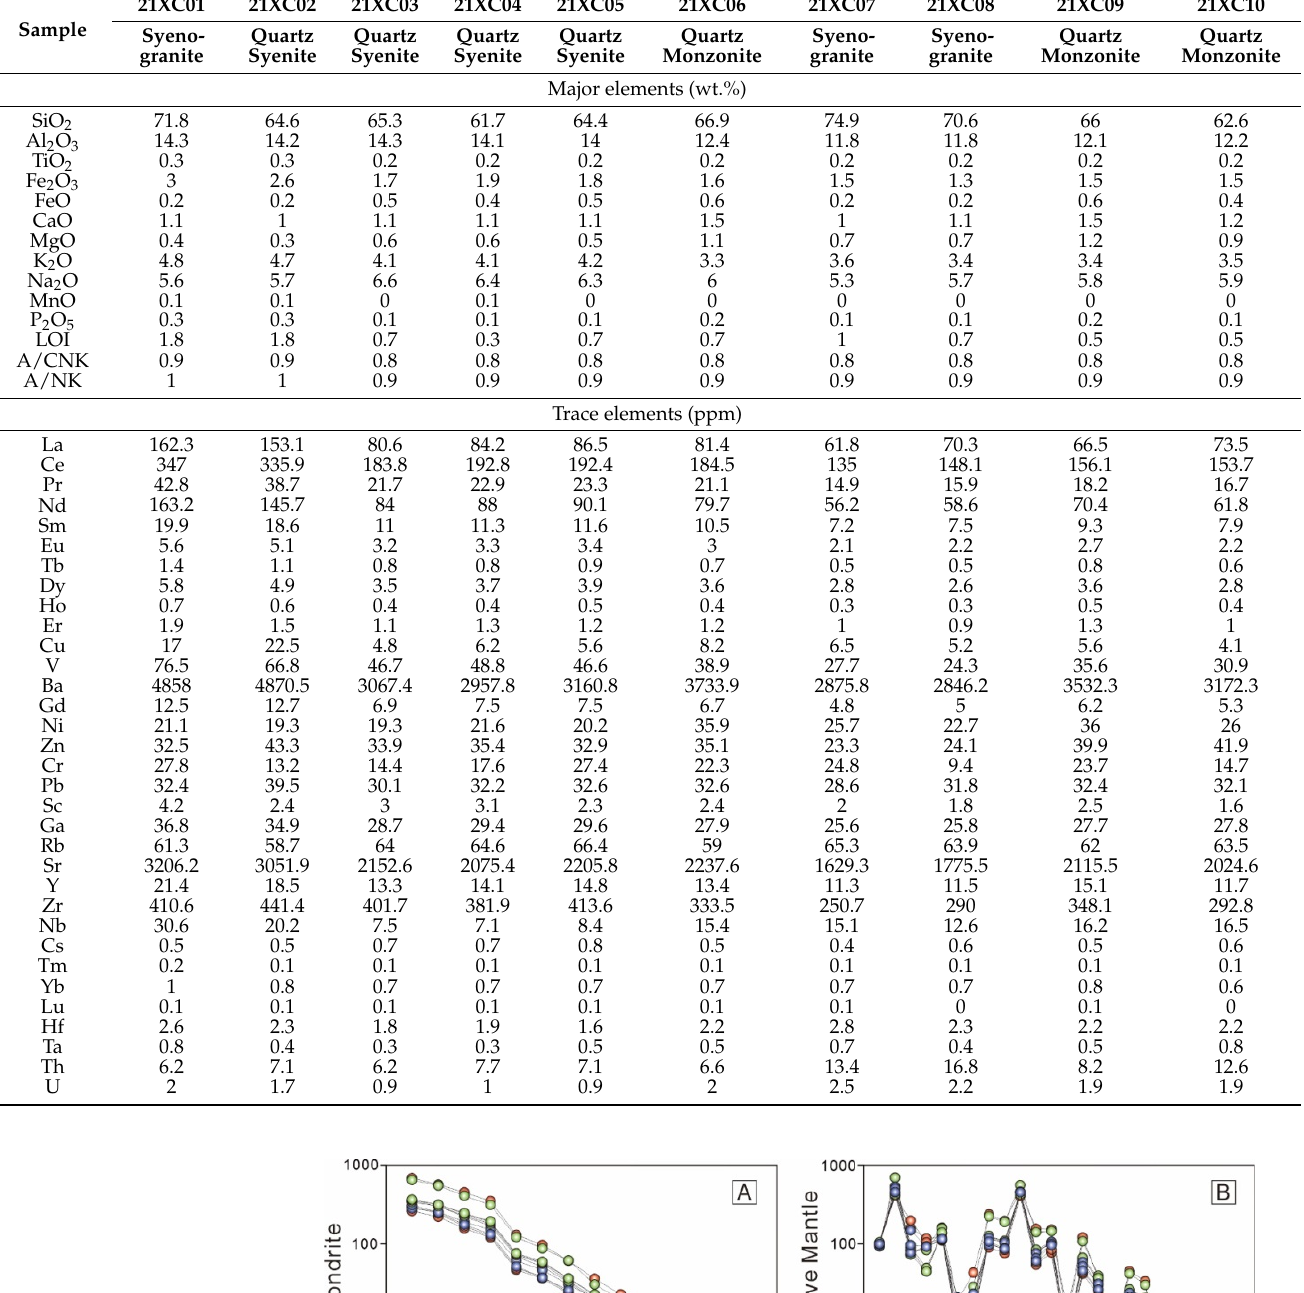
Table 1. Major and trace element compositions for the alkaline rocks.